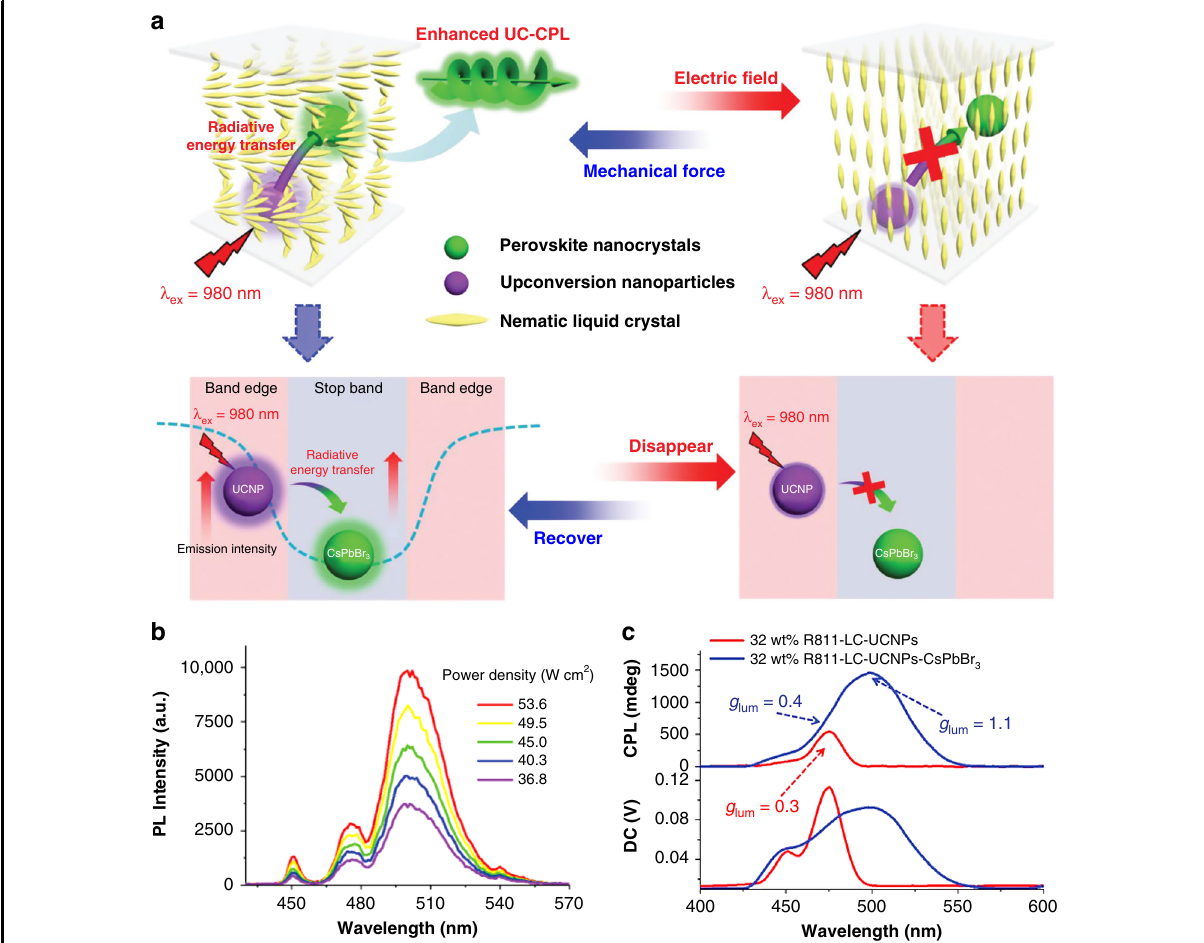
Fig. 12 Chiral upconversion nanoparticles based on chiral liquid-crystalline template. a Schematic illustration of switchable CPL in chiral UCNPs under electric fi eld. b Upconversion emission spectra of chiral UCNPs with different incident excitation intensities of 980 nm NIR light. c Upconversion CPL spectra of chiral UNCPs upon NIR irradiations. Reproduced with permission from ref. 304 . Copyright 2020,